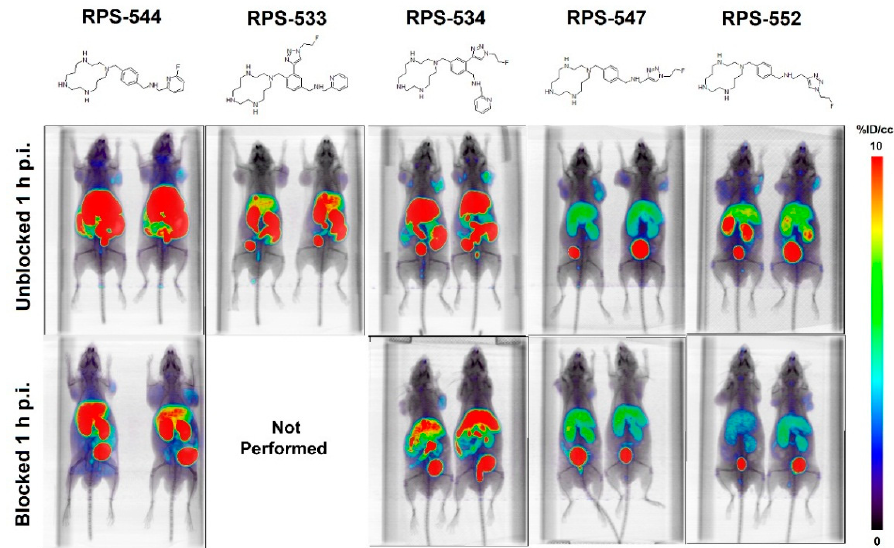
Figure 3. Maximum intensity projection µPET/CT images of male BALB/C nu/nu mice bearing PC3-WT xenograft tumors (left shoulder) and PC3-CXCR4 xenograft tumors (right shoulder). Images were